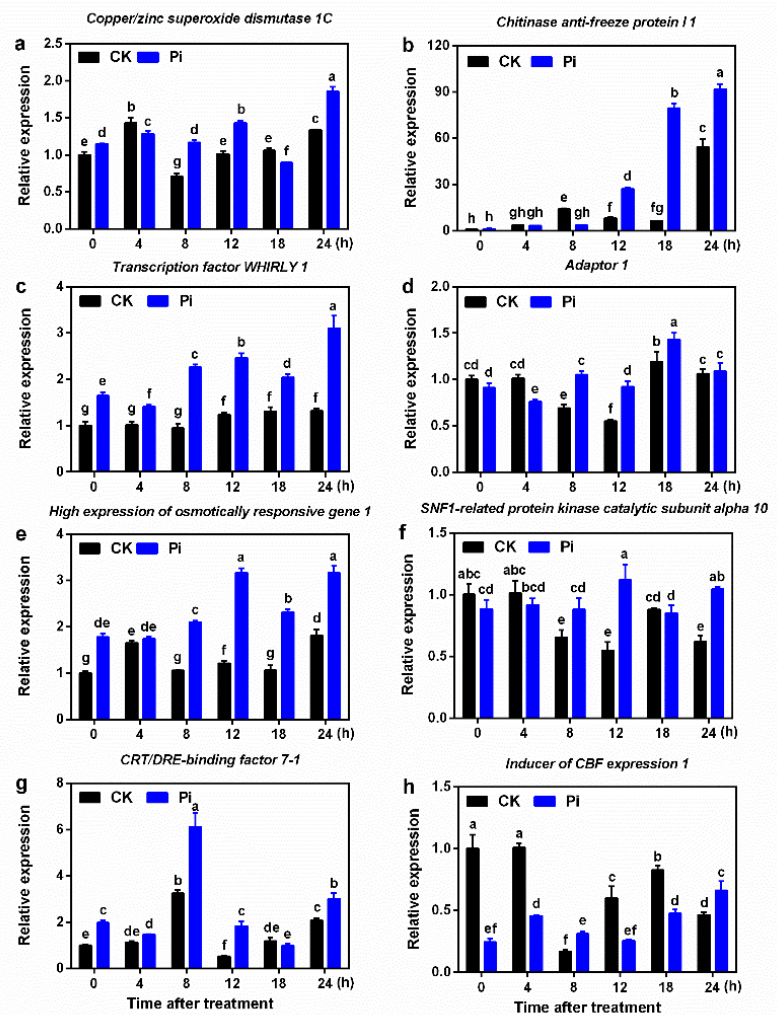
Figure 5. The relative gene expression levels of ( a ) copper/zinc superoxide dismutase 1C ( CSD1C ), ( b ) chitinase anti-freeze protein I 1 (ChiI 1 ), ( c ) transcription factor WHIRLY 1 ( Why 1 ), ( d ) ADA1 , adaptor 1, ( e ) high expression of osmotically responsive gene 1 ( HOS1 ), ( f ) SNF1-related protein kinase catalytic subunit alpha 10 ( KIN10 ), ( g ) CRT/DRE-binding factor 7-1 ( CBF7-1 ) and ( h ) inducer of CBF expression 1 ( ICE1 ) from P. indica -colonized and non-colonized banana were analyzed and compared across the time course of cold stress. Values represent means ± standard deviation of three replicates. Different lowercase letters above the bars indicate statistically significant differences at the 0.05 level from CK (0 h) between the CK and Pi groups by Duncan’s multiple-range test. Error bars represent SDs ( n =